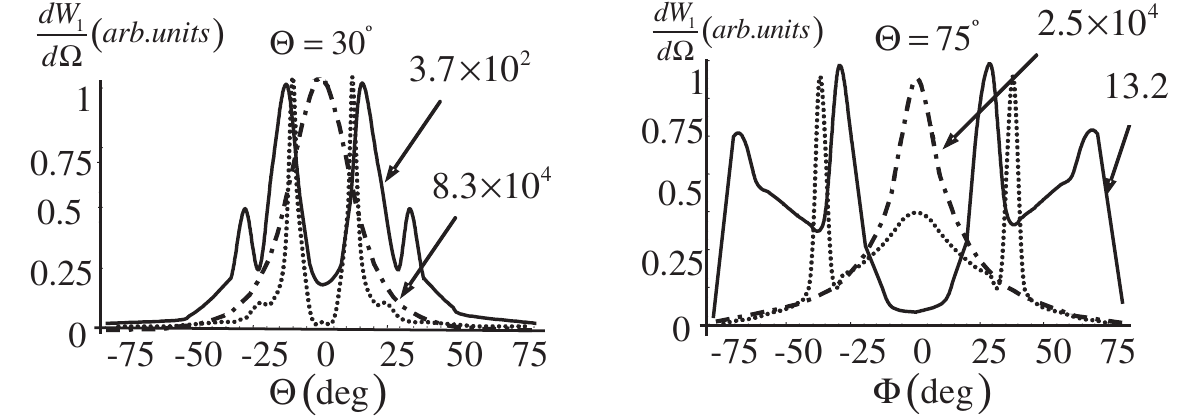
FIG. 10. Azimuth distribution of the SPR intensity according to van den Berg’s model ( (cid:1) (cid:5) 12 , d (cid:5) 8 mm , a (cid:5) d= 2 , h (cid:5) 1 mm , (cid:5) b (cid:5) 4 mm ; a dotted line—lamellar grating; solid line—grating with vacuum gaps), according to SC model ( (cid:1) (cid:5) 12 , b vol gr lam gr (cid:5) 4 mm ; a dash-dotted line—lamellar grating). d (cid:5) 8 mm , a (cid:5) d= 2 , h (cid:5) 1 mm , b lam gr